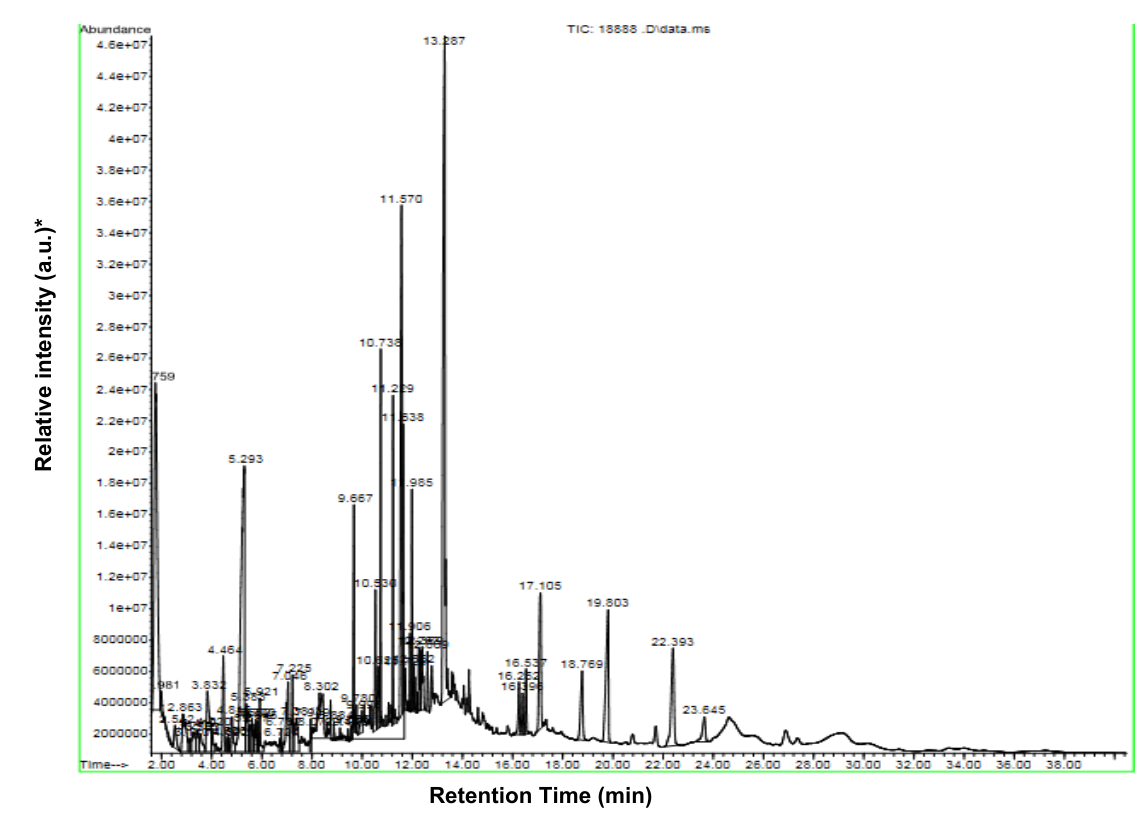
Figure 1. Gas chromatography and mass spectrometry chromatogram showing the major components of the aqueous bulb extract of Drimia maritima . * a.u.: arbitrary unit. Table 1. Gas chromatography and mass spectrometry data of chemical components of Drimia maritima bulb